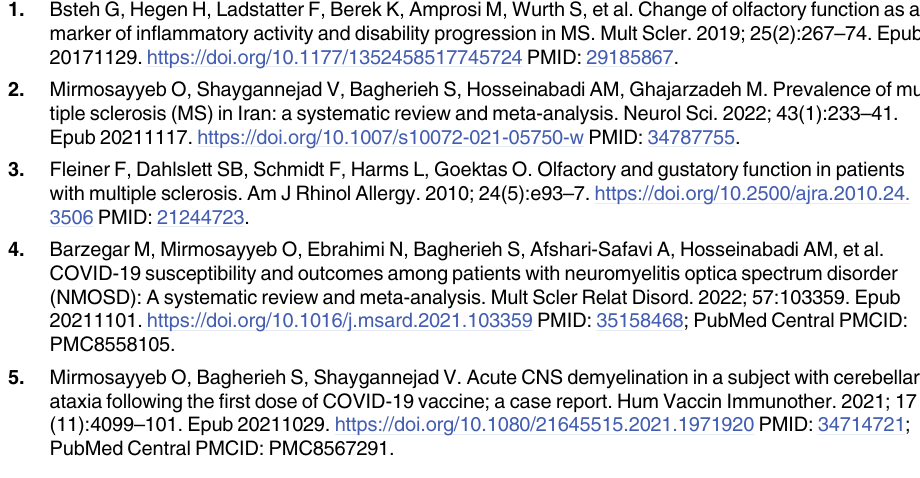
S2 Fig. Overall level of threshold. (JPEG) S3 Fig. Overall level of discrimination. (JPEG) S4 Fig. Overall level of identification.